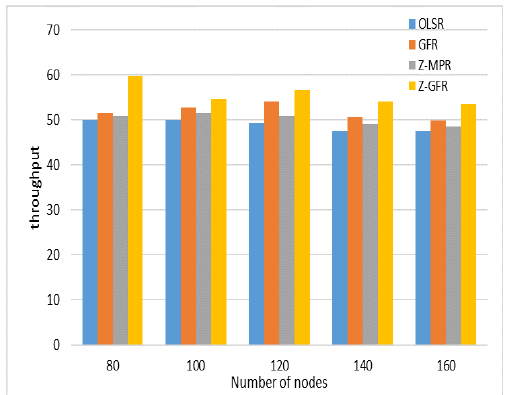
Figure 20. Throughput of the udp